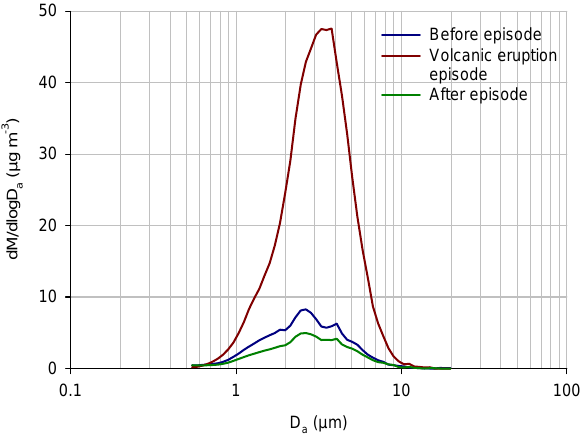
Fig. 5. APS-derived mass size distributions of super-micron parti- cles before the volcanic episode (03:00–06:00 local summer time on 25 May), during the episode (06:30–17:30), and after it (18:00– 21:00). A density of 2.6gcm − 3 has been assumed in converting the APS data.